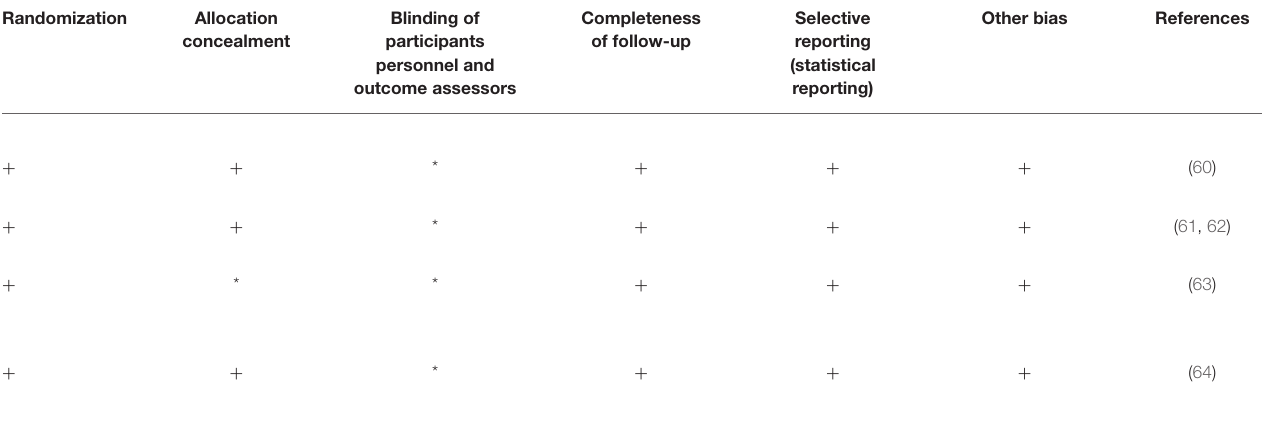
TABLE 1 | Qualitative analysis of the included controlled clinical trials (sinus